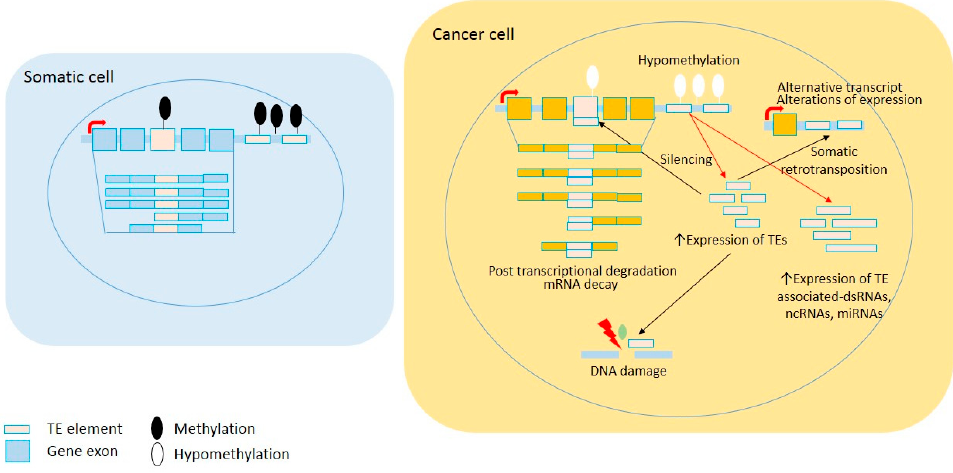
Figure 1. Global loss of DNA methylation in cancer cells leads to TE reactivation. A common epigenetic feature in neoplastic cells is global demethylation, including within repeated sequences. Subsequently, TE reactivation can cause increasing somatic retrotransposition, non-coding RNA, and transcriptional deregulation. Red arrows show direct impacts of TE reactivation and black arrows show effects of retrotransposition.